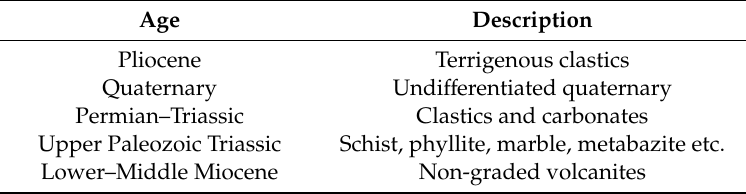
Table 5. Age and general descriptions of the lithologies in the study area